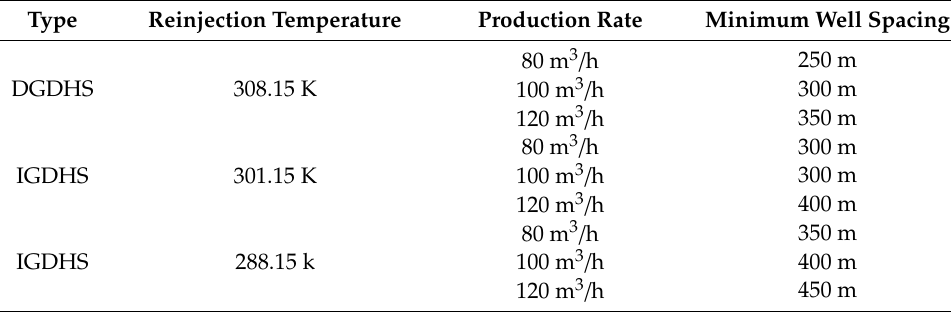
Figure 12. Temperature distribution nephograms of a IGDHS with reinjection temperature of 288.15 K in the 50th year: ( a ) radius of cold water thermal front; ( b ) production rate of 80 m 3 / h; ( c ) production rate of 100 m 3 / h; ( d ) production rate of 120 m 3 / h. Table 2. Optimal well spacing for di ff erent geothermal heating systems.